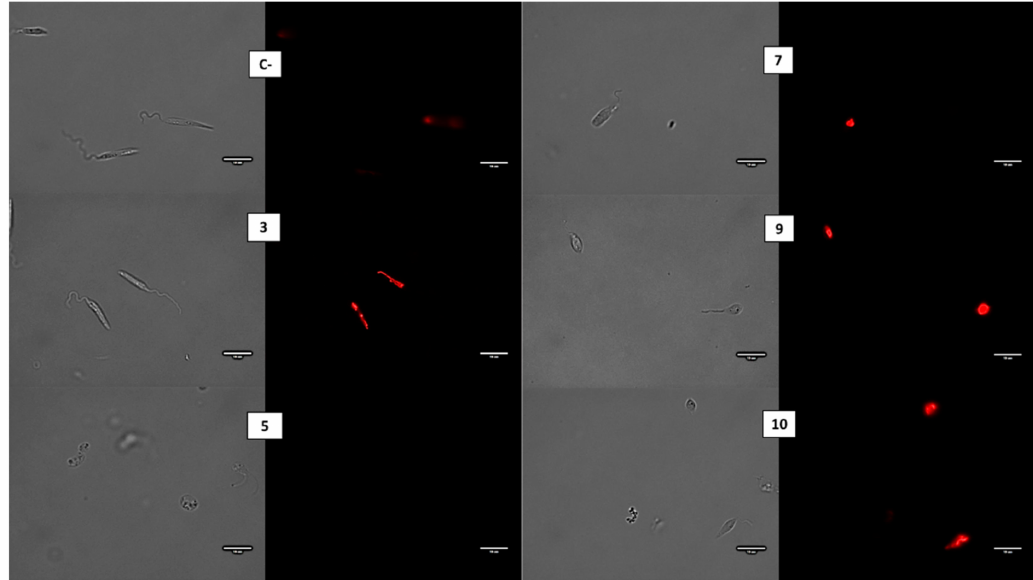
Figure 3. CellROX Deep Red staining. Results after 24 h of incubation of L. amazonensis promastigotes with the IC 90 of compound. C-: Control. Images were captured using an EVOS FL Cell Imaging system (Thermo Fisher Scientific) (100 × ). Scale: 10 µ